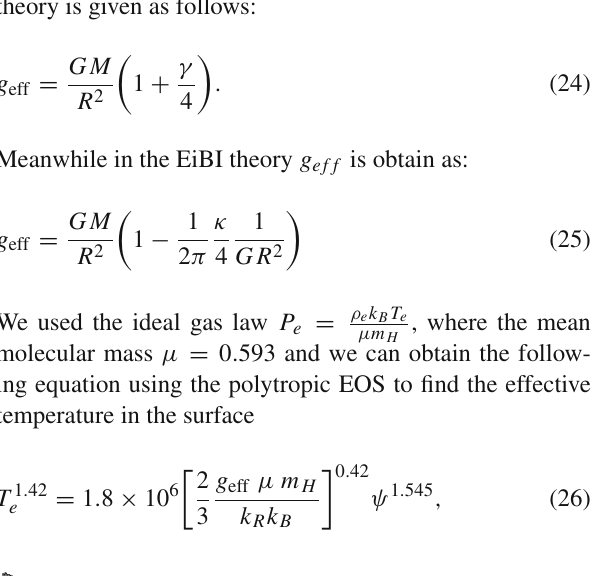
Fig. 6 MMHB and M (DB limit) as a function of the κρ A parameter of EiBI theory with k R = 10 − 2 cm 2 / g. With this effective temperature in hand we can calculate the photo sphere luminosity as